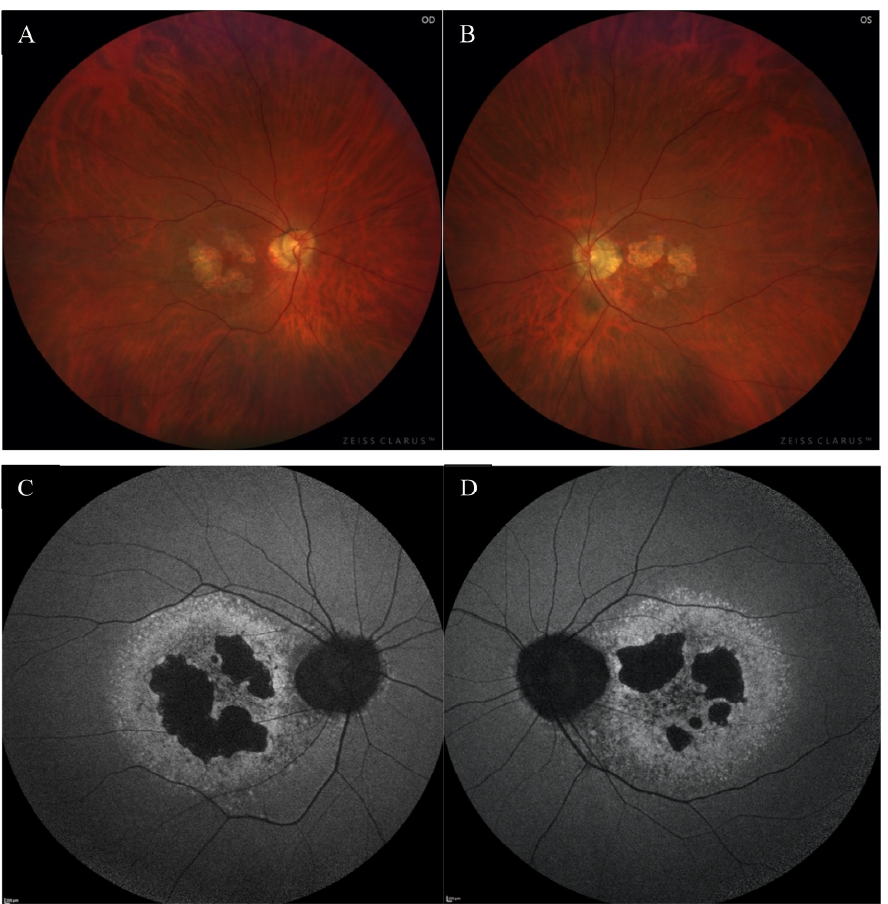
Figure 1. The color fundus images of the right ( A ) and the left ( B ) eye showed macular degenerations, retinal thinning, as well as an atrophic area around the optic disc. FAF of both eyes ( C , D ) disclosed hypoautofluorescence in the macula with a surrounding rim of hyperautofluorescence, as well as hypoautofluorescence around the optic